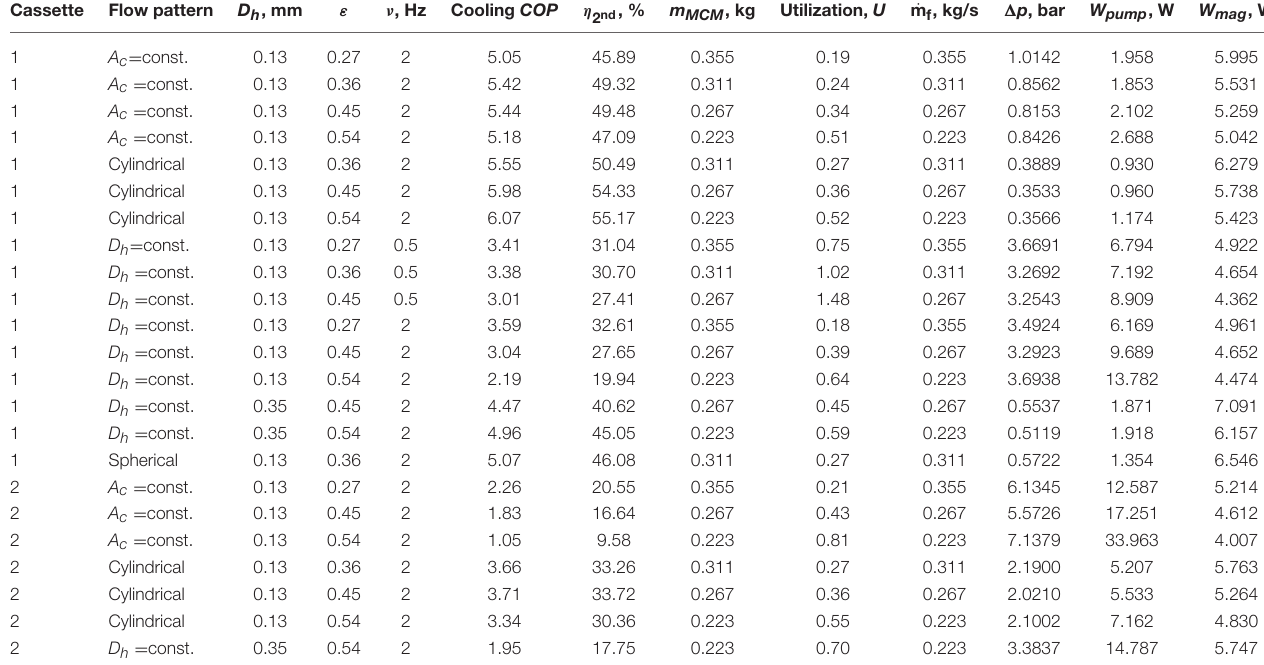
TABLE 4 | Performance of all modeled regenerators at Q cool = 40W. Cassette Flow pattern D h ,